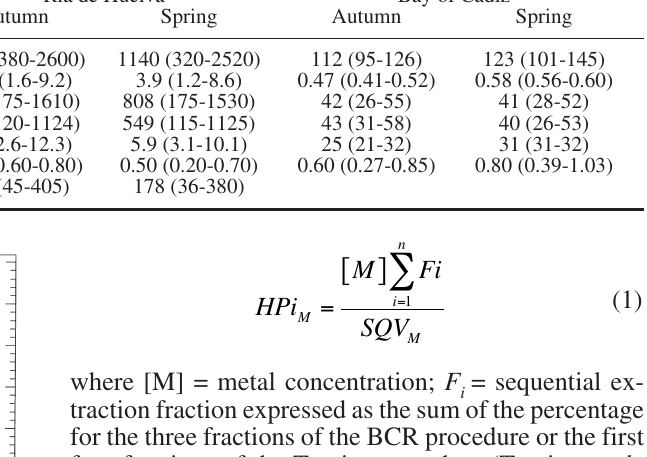
Table 1. – Average and range concentration for the analyzed metal at the three locations in the two sampling campaigns. Results are expressed Metal